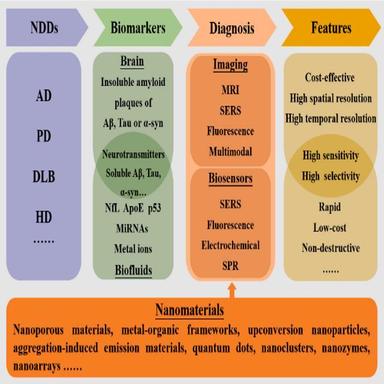
Schematic illustration of nanomaterials-involved diagnosis of neurodegenerative diseases.